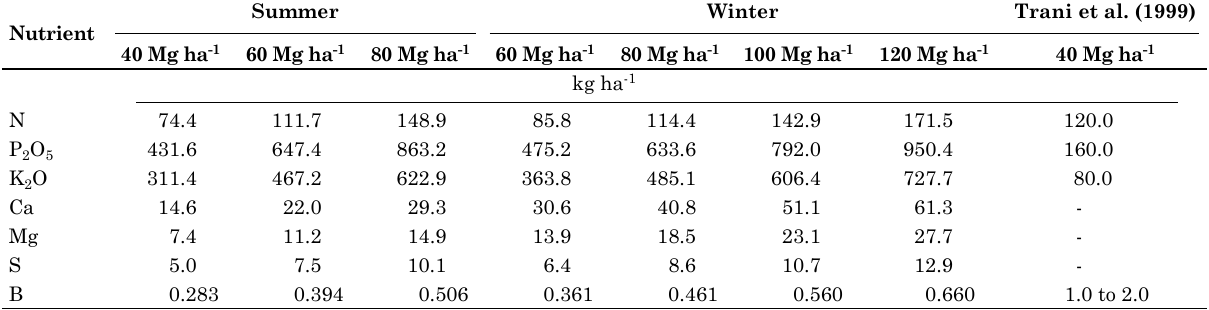
table 5. recommendations of application rates of N, p 2 o 5 , K 2 o, ca, mg, S, and B generated by ferticalc carrot and by the literature for different intended yields of roots in the winter and summer crops